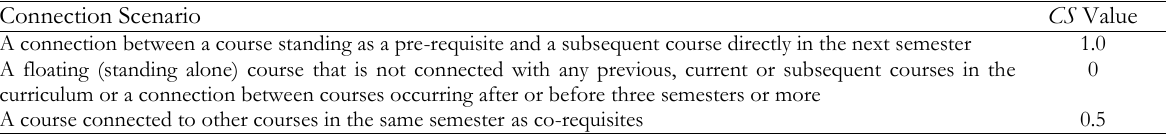
Table 1. Logical Connection Strength ( CS )